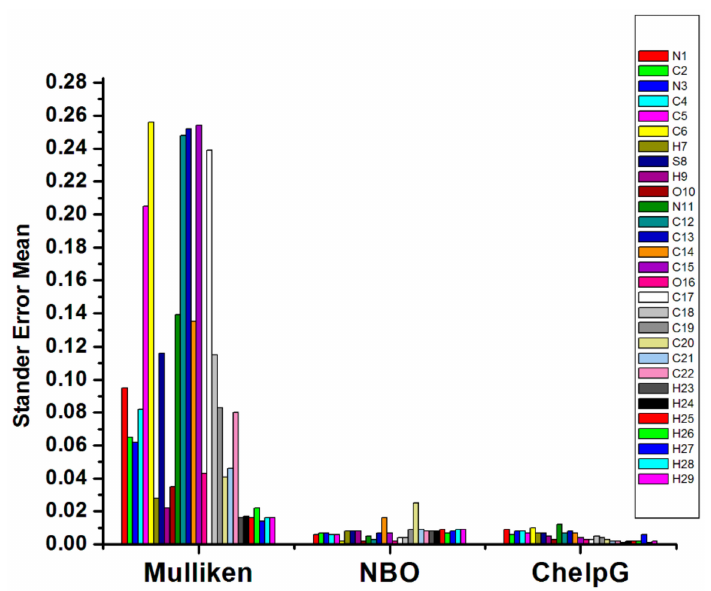
Figure 4. Standard error mean of partial charges of compound 1H using B3LYP level of theory with di ff erent basis sets.